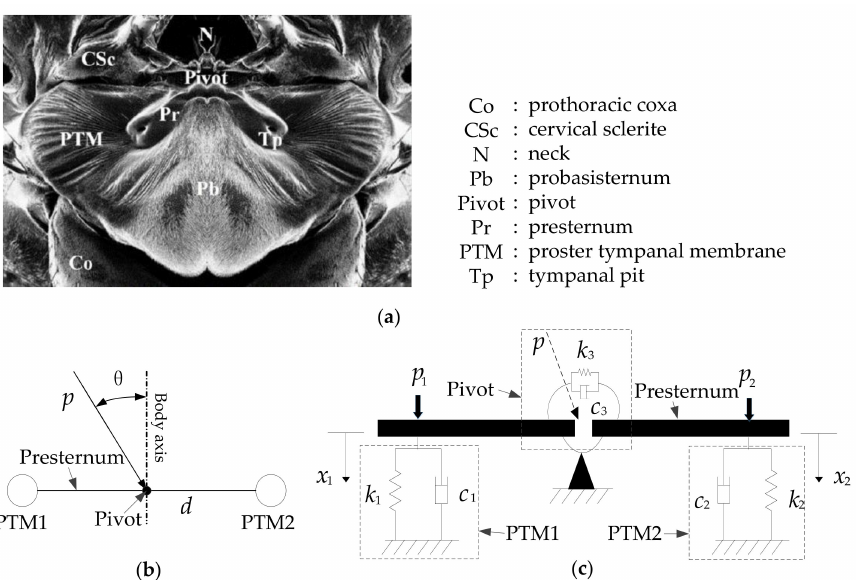
Figure 2. External anatomy and equivalent 2-DOF model and parameters of O. ochracea’s ears. ( a ) External anatomy of the ears of O. ochracea [5]. ( b ) The relationship between the incident angle of the sound source and the body axis of O. ochracea . ( c ) Mechanical model of the ears of O. ochracea by Miles R.N.